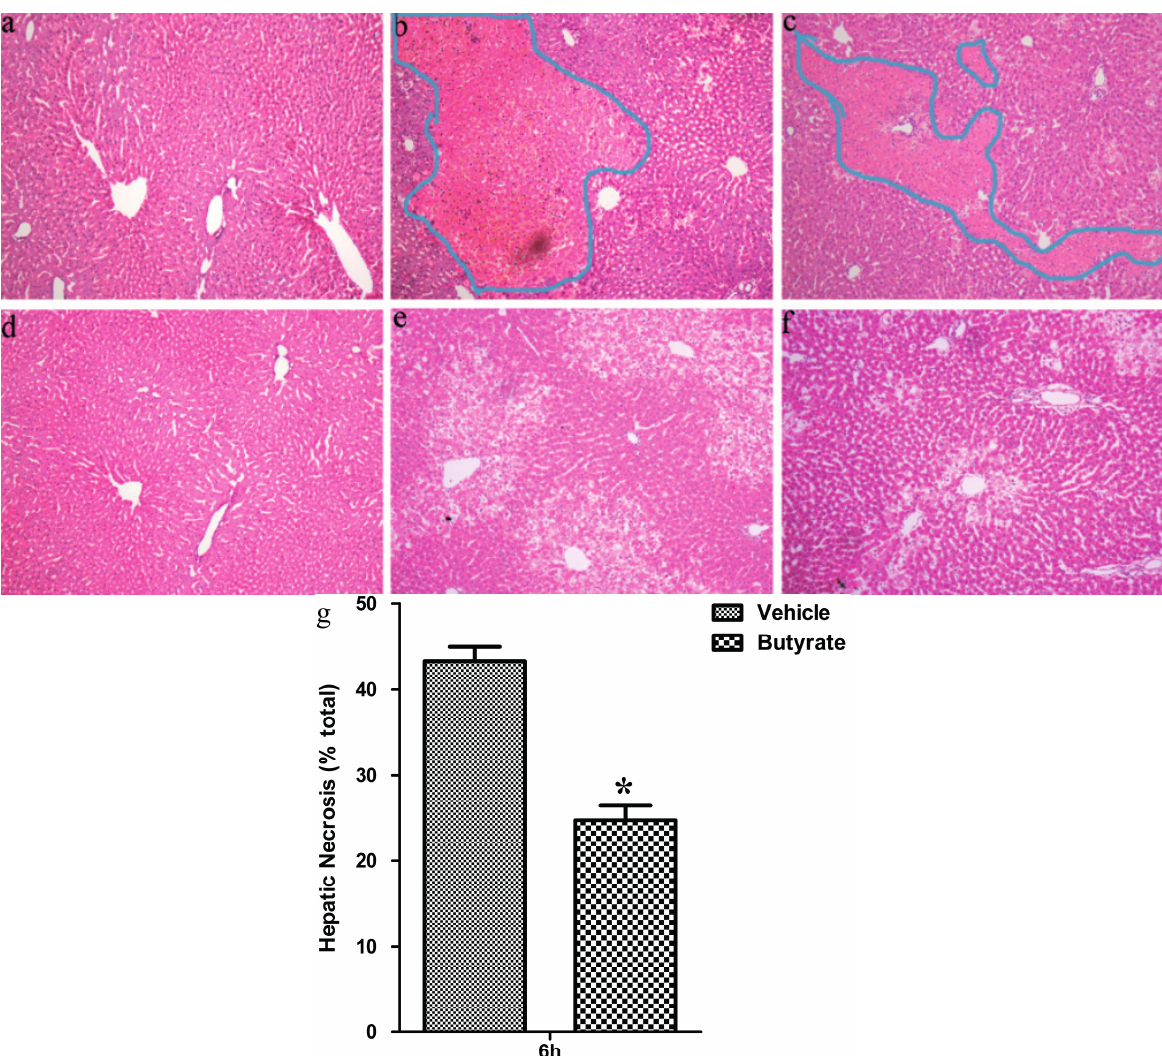
Figure 2. Hematoxylin–eosin (HE)-stained liver sections from the sham ( a , d ); vehicle ( b , e ); and butyrate ( c , f ) groups at 6 h ( a – c ) and 24 h ( d – f ) after reperfusion (original magnification: 200×), with the outlined areas in the blue line ( b , c ) showing hepatic necrosis area ( g ). Severe liver injury indicated by hepatocellular necrosis, sinusoidal congestion, and neutrophil infiltration was present in the vehicle group, whereas less damage was noted after butyrate treatment. * p < 0.05 vs. the vehicle